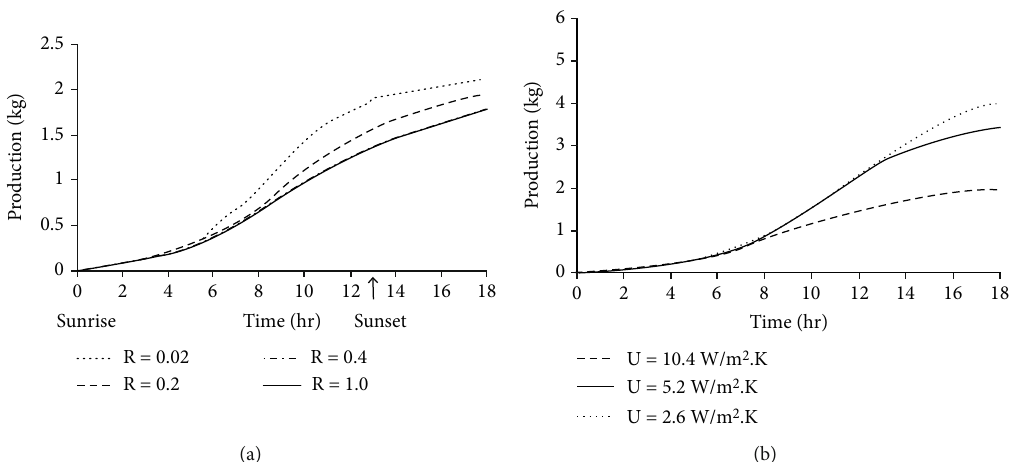
Figure 25: Productivity a ff ected by (a) the ratio of the phase change material mass to water mass and (b) the heat transfer coe ffi cient [73].